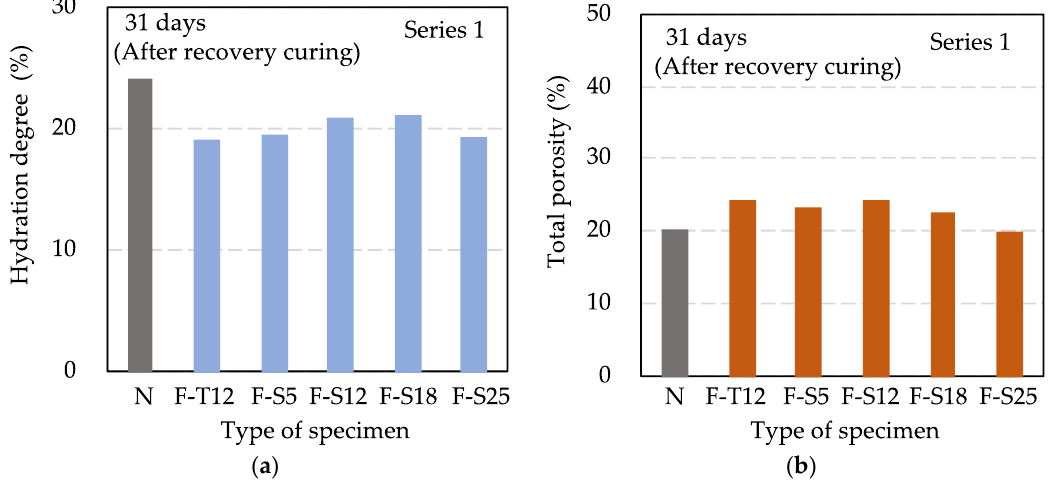
Figure 5. Results of hydration degree ( a ) and total porosity ( b ) in Series 1 at 31 days.